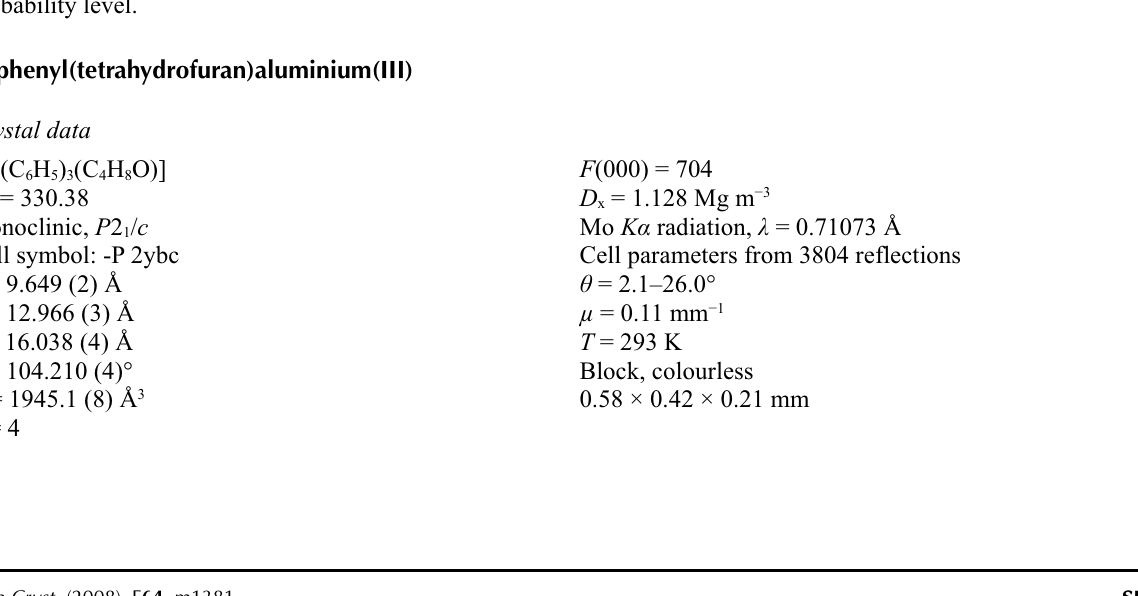
The molecular structure of the title compound with atom-numbering and displacement ellipsoids drawn at the 20% probability